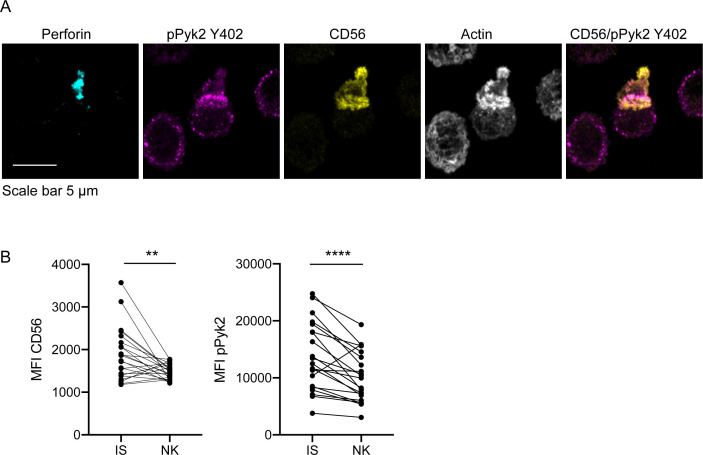
CD56 co-localizes with pPyk2 Y402 to the immune synapse in primary human NK cells.Primary NK cells were enriched from peripheral blood then incubated with K562 target cells for 45 min on poly-L-lysine coated coverslips in the presence of non-blocking anti-CD56 antibody. Following incubation cells were fixed, permeabilized, and immunostained for pPyk2 Y402 (magenta), perforin (cyan) and actin (phalloidin, greyscale). 3D volumetric images were acquired by spinning disk confocal microscopy. (A) Representative images from one of three healthy donors. Shown is a maximum projection of 13 planes taken with 0.5 µm steps. (B) Fluorescence intensity of CD56 (left) or pPyk2 Y402 (right) measured at the synaptic (IS) or non-synaptic (NK) cell cortex of primary NK cells conjugated to target cells. n = 22 from one independent experiment of 3 using three different healthy donors. **p<0.005, ****p<0.0001 by paired t-test.